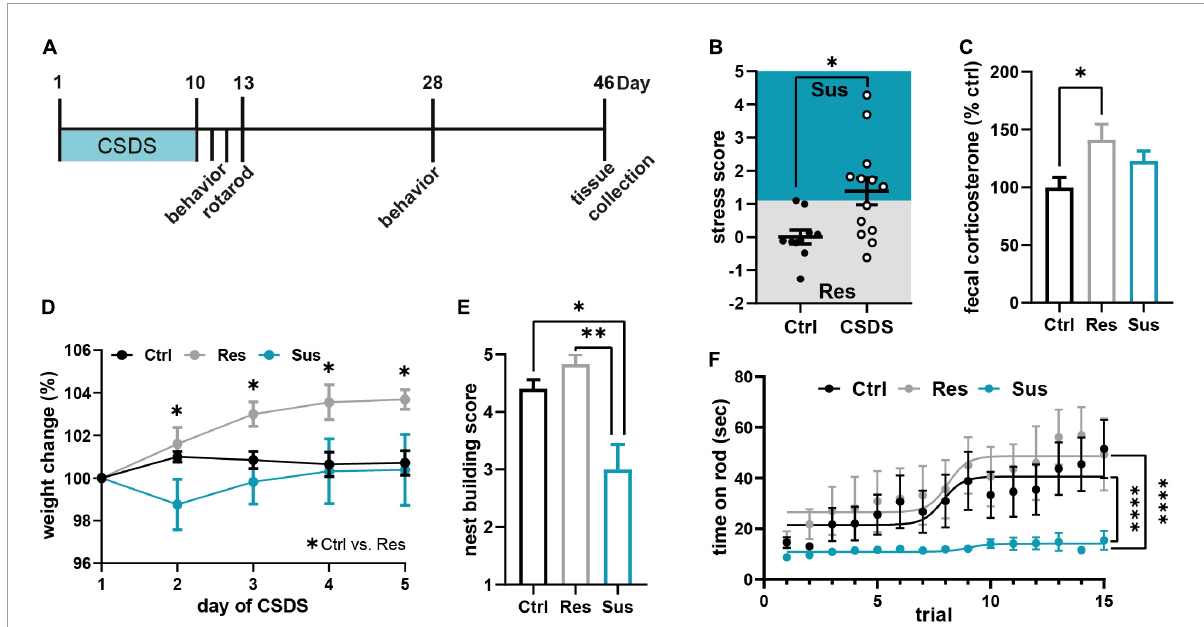
FIGURE1 Chronic social defeat stress (CSDS) induces severe and lasting behavioral and physiological changes. (A) Experimental timeline. (B) Stress score derived from three behavioral tests [sucrose preference test (SPT), nestlet shredding test (NST), social avoidance test (SAT); Supplementary Figure 1 ] classified mice as stress susceptible or resilient. (C) Cumulative fecal corticosterone (CORT) levels from 24 h post CSDS normalized to the control group. (D) Weight development of the three behavioral groups during the first 5 days of CSDS. (E) Chronic stress-induced changes in the nest building test on day 28, 18 days post CSDS. (F) Motor learning assessed by the accelerating rotarod task 3 days post CSDS. ∗ P < 0.05, ∗∗ P < 0.01, ∗∗∗∗ P < 0.0001. Results are shown as mean ±